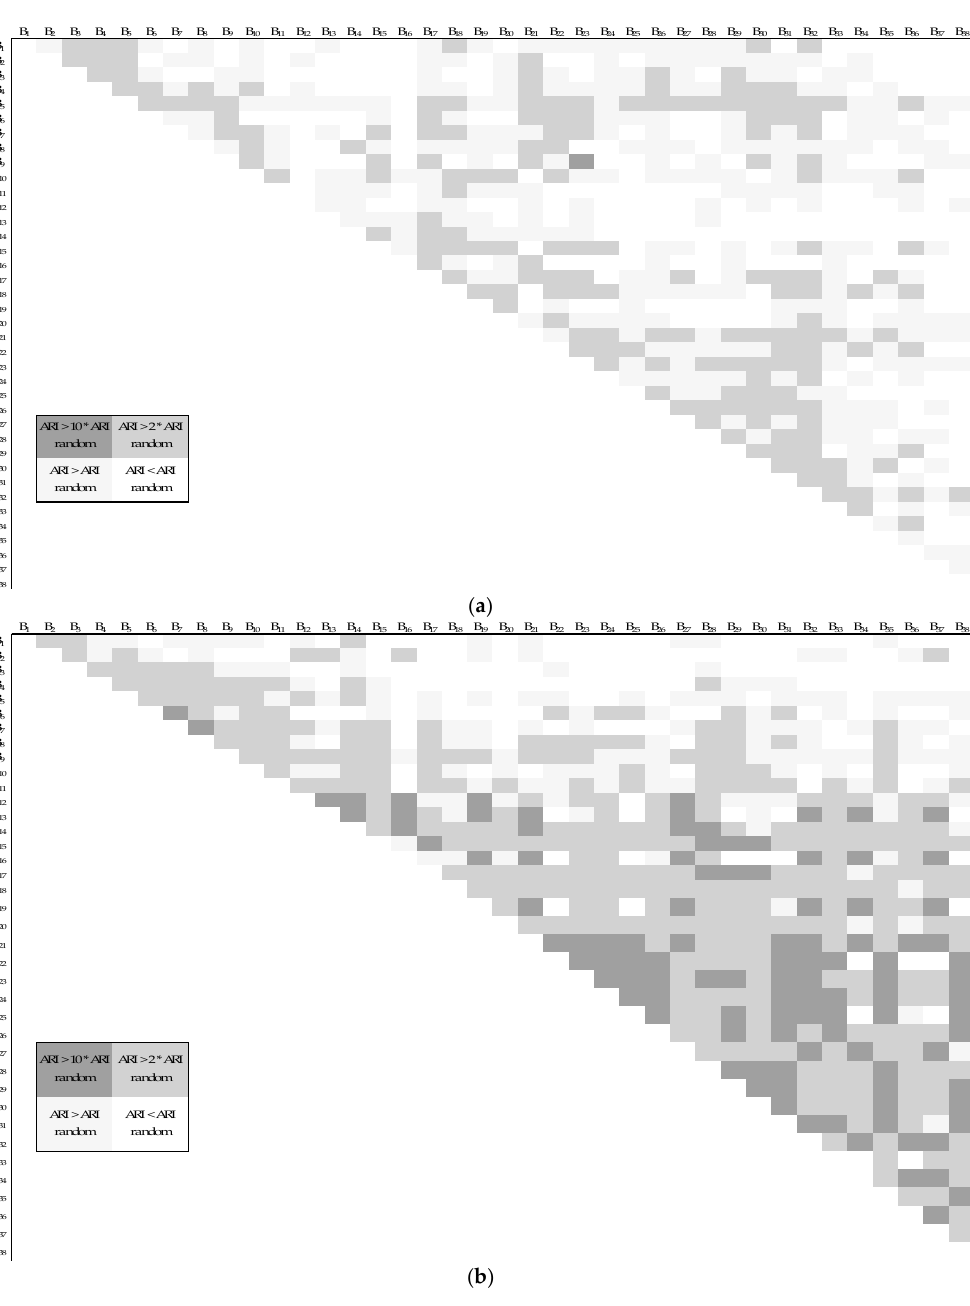
Figure A6. ARI results for 𝑚𝑖𝑛𝑆𝑒𝑟𝑖𝑒𝑠 set at 1% and window length 𝑤 set at 14 days (the short-term version is presented on the upper part ( a ) while the long-term version is on the bottom part of the figure ( b )).